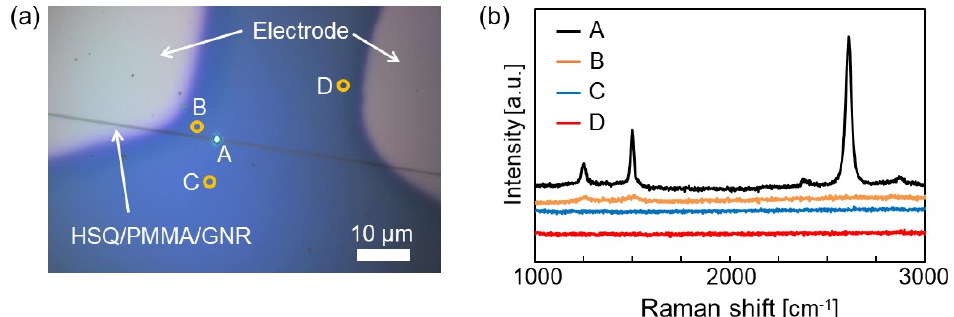
Figure 4. ( a ) Measurement points for Raman spectrum data. The white area in the figure is the metal electrode, and the black line in the center of the figure is the HSQ/PMMA/GNR. ( b ) Raman spectra of the indicated measurement points; A is the HSQ/PMMA/GNR layer, and B, C, and D are etched areas.